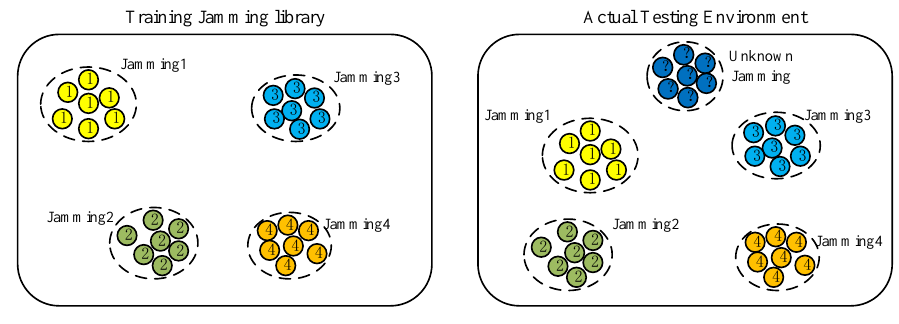
Figure 3. The open set jamming